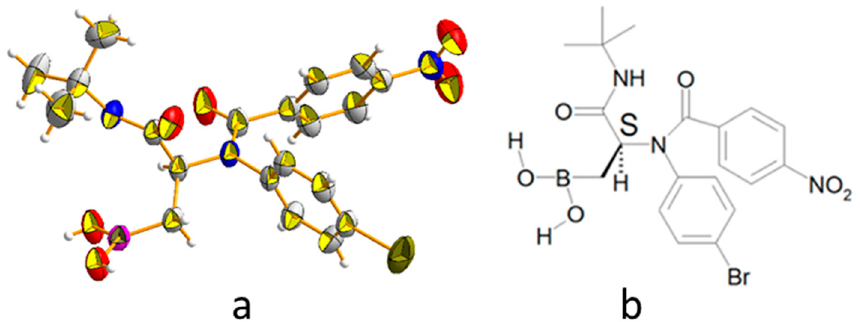
5 of 21 Figure 1. a ) Asymmetric unit of 5a . Thermal ellipsoids at RT were drawn at the 30% probability level (C: gray; H: white; O: red; N: blue; B: purple; Br: dark green). The only relevant NH–O intramolecular hydrogen bond is highlighted as a red dashed line. b ) Molecular structure of the S- 5a enantiomer (also the R enantiomer is present in the crystal in a 1:1 ratio) [26]. In order to provide unprotected boronic acids for biological evaluation, reference compound 5a was subjected to 3M HCl in acetonitrile, for removal of MIDA according to literature procedure. The corresponding β -aminoboronic acid 6a could be isolated in a good yield after reverse-phase chromatographic purification, which allowed removing a small quantity of tertiary amide hydrolysis byproduct. Aiming at a cleaner protocol, also suitable for acid-labile compounds, an alternative, basic MIDA-deprotection was applied, treating compound 5a with excess of sodium carbonate in dry methanol, at room temperature for four h. Compound 6a was recovered quantitatively, without the need for purification. Said protocol was extended to all MIDA-protected compounds and afforded the desired β -aminoboronic acids 6 in excellent yields, also in the presence of susceptible methyl acetate groups (compounds 6o – p ). The free boronic acids 6a – p proved to be quite stable towards the common protodeborylation